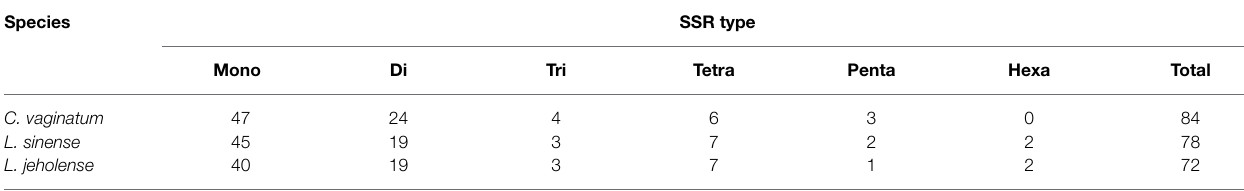
TABLE 3 | Types and amounts of simple sequence repeats (SSRs) in the chloroplast genomes of C. vaginatum , L. sinense , and L. jeholense . Species SSR type Mono Di Tri Tetra Penta Hexa Total